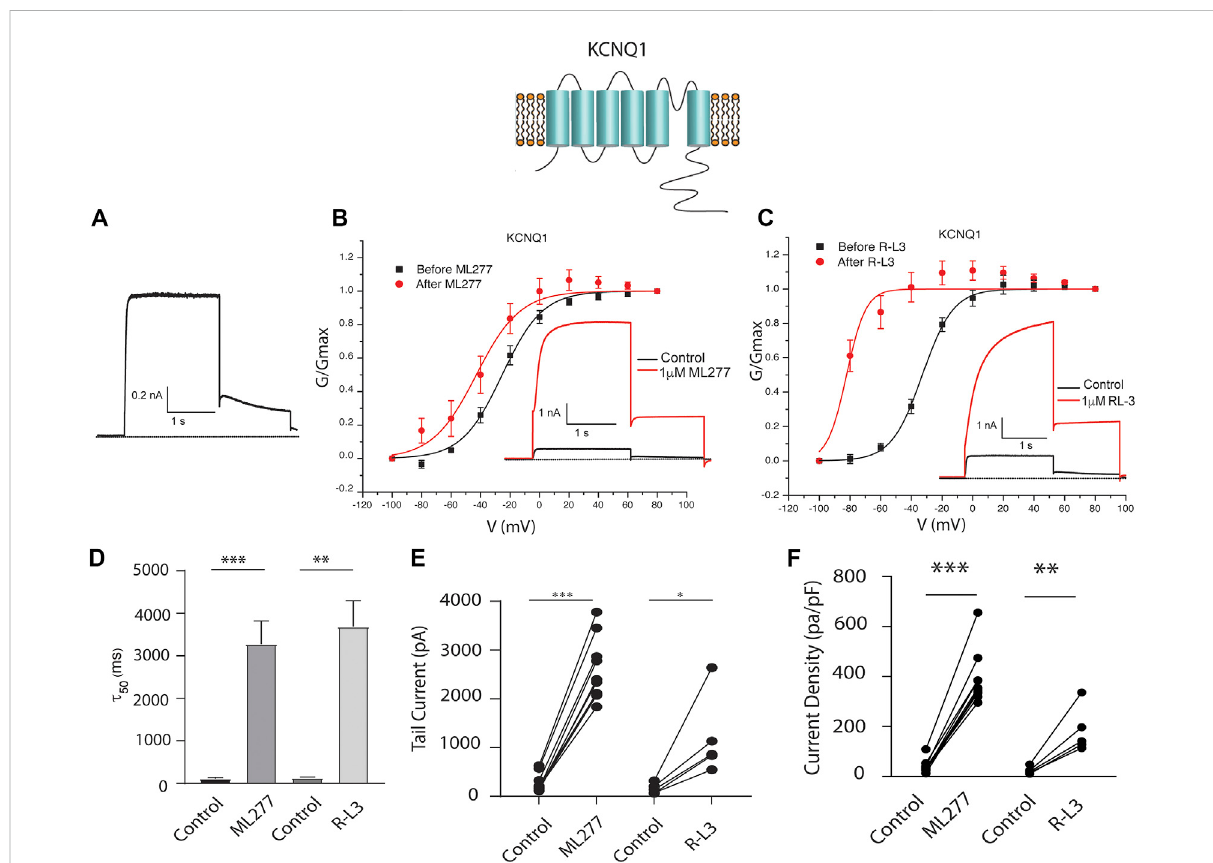
FIGURE 1 ML277 and R-L3 modulate wild type IKS channels in the absence of KCNE1. Individual current traces recorded in response to 2 s depolarizing stepsto+60 mVfrom (A) 70 mVholdingpotentialareshownasinsetsinpanels (B,C) .Currentsareshownintheabsence(blacktraces)andpresence (red traces) of test drugs. (A) . Control drug-free recording of wild type KCNQ1 channel activity. (B) . KCNQ1 conductance-/voltage relationships recorded in the absence (black) and presence (red) of 1 μ M ML277. (C) . KCNQ1 conductance-/voltage relationships recorded in the absence (black) and presence (red) 1 μ M R-L3. (D) . Deactivation tail time constants measured at − 40 mV in the absence (control) and presence of 1 μ M ML277 and 1 μ M R-L3. (E) . KCNQ1 tail current amplitude (measured at − 40 mV) in the absence (control) and presence of ML277 (1 μ M) and